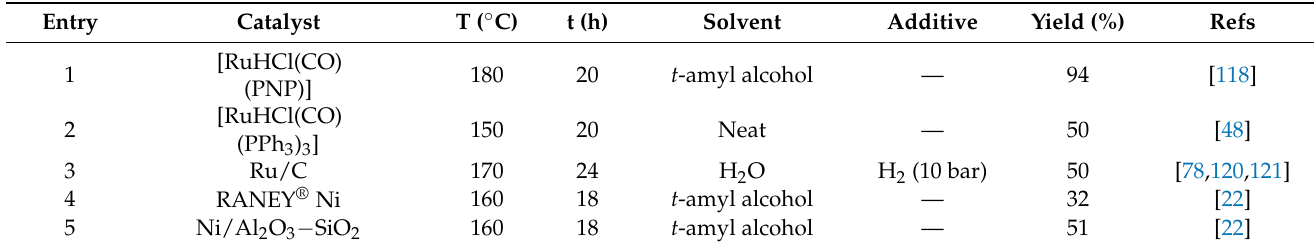
Table 7. Catalytic isohexides mono-amination using ammonia as a nitrogen source.